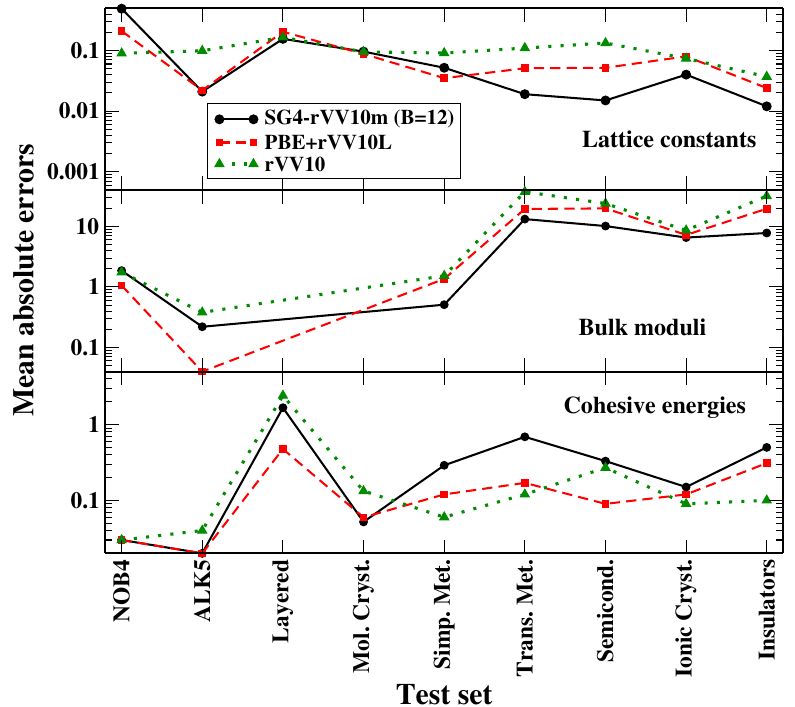
Figure 3. Mean absolute errors of different functionals for the lattice constants ( upper panel, Å), bulk moduli ( middle panel; GPa), and cohesive energies ( bottom panel, eV or eV/bohr 2 ) of various test